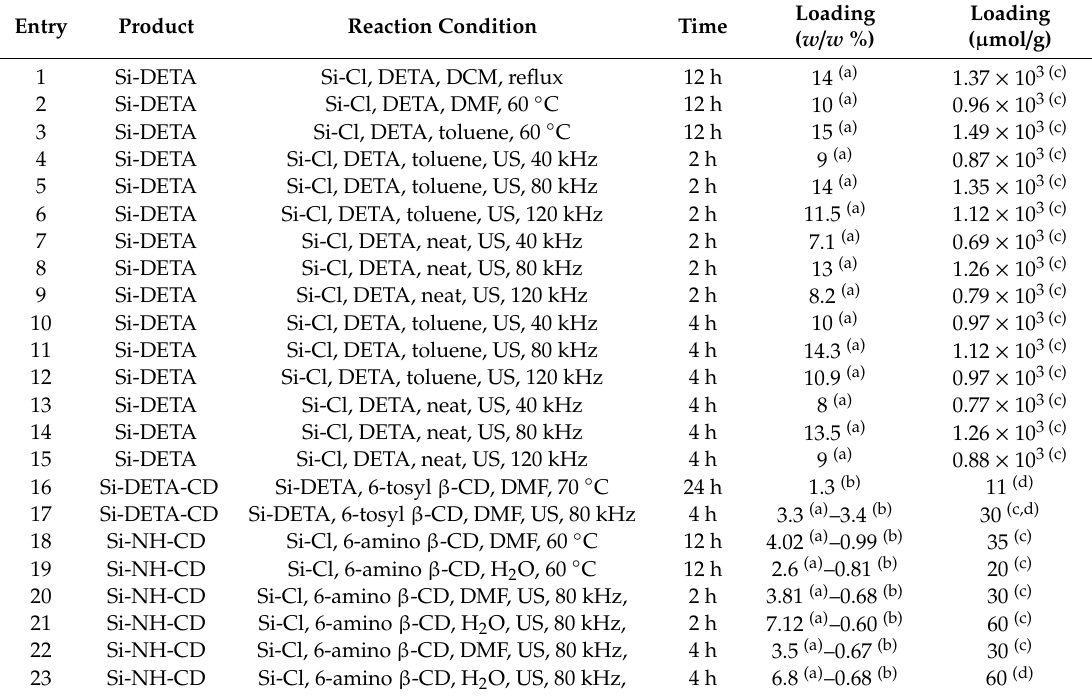
Table 1. Synthesis of grafted silica.